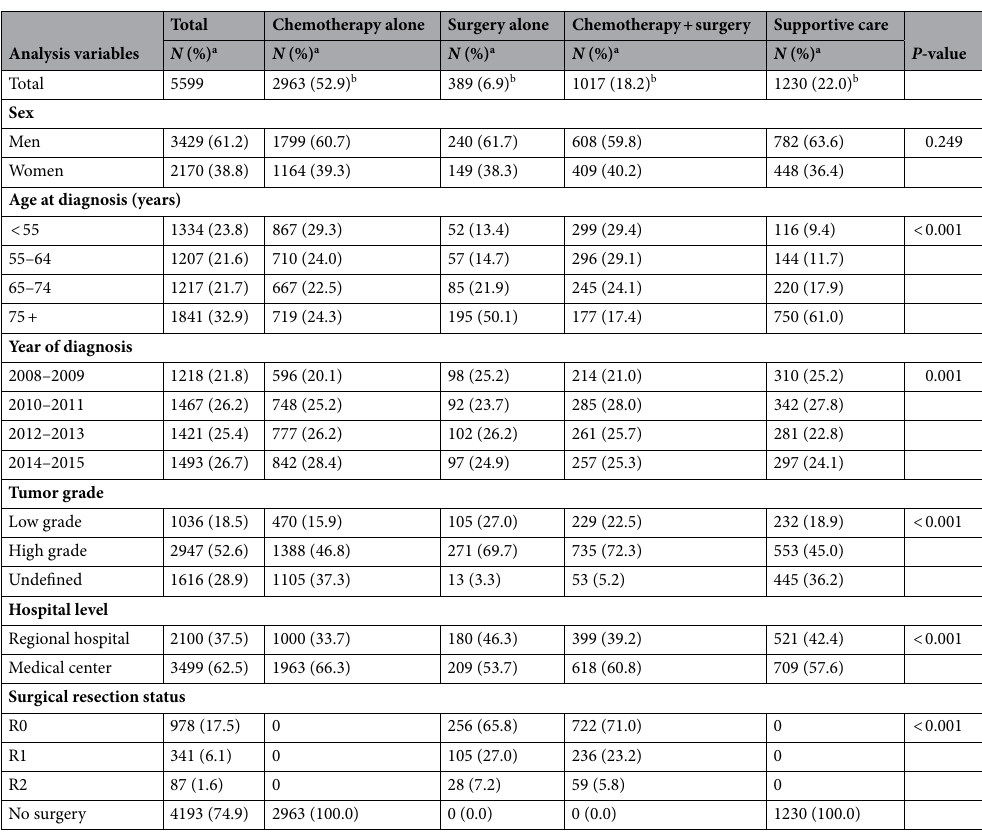
Table 1. Demographic characteristics of M1 Stage IV gastric cancer patients by different treatment modalities from 2008 to 2015 in Taiwan. a Percentages are vertically summed up to 100% for each analysis variable. b Percentages are horizontally summed up to be